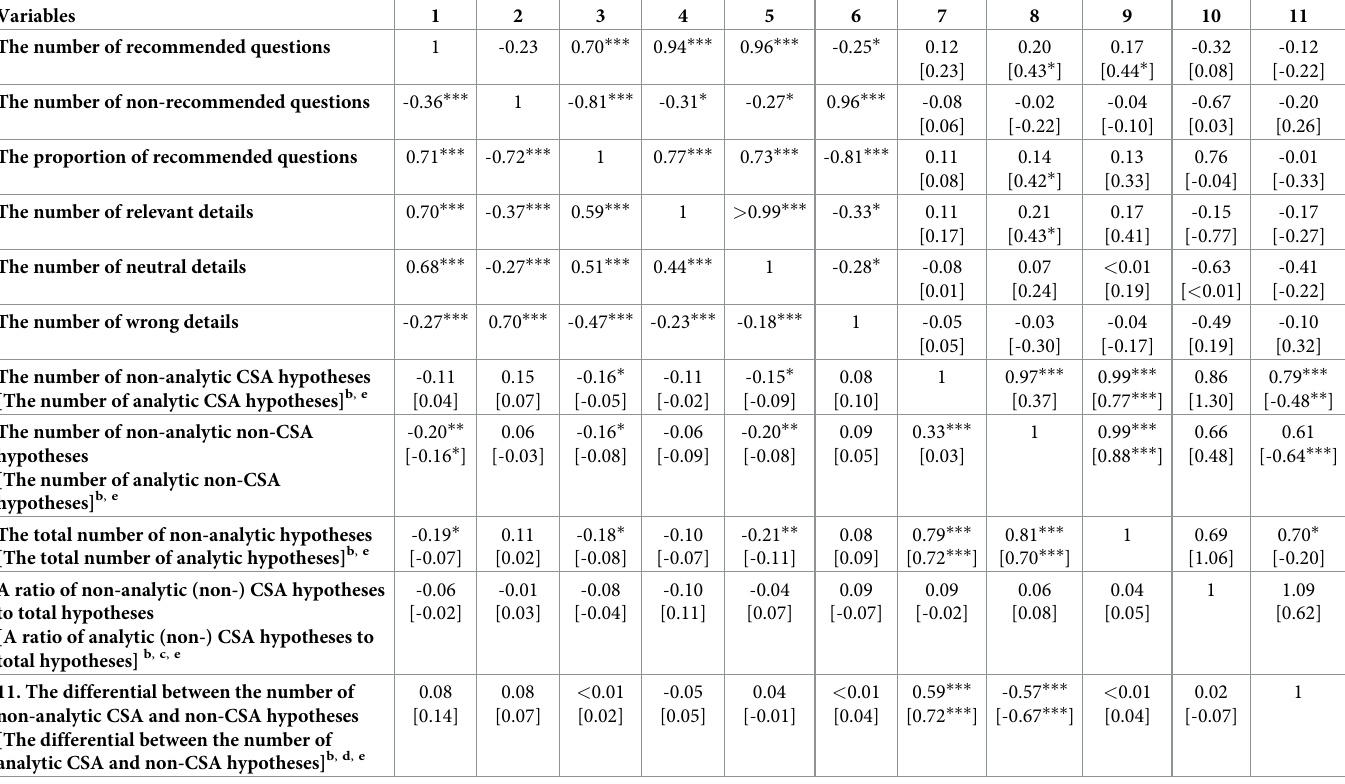
Table 9. a, f Within-subject and between-subject correlations between types of questions, types of details, and hypotheses built.